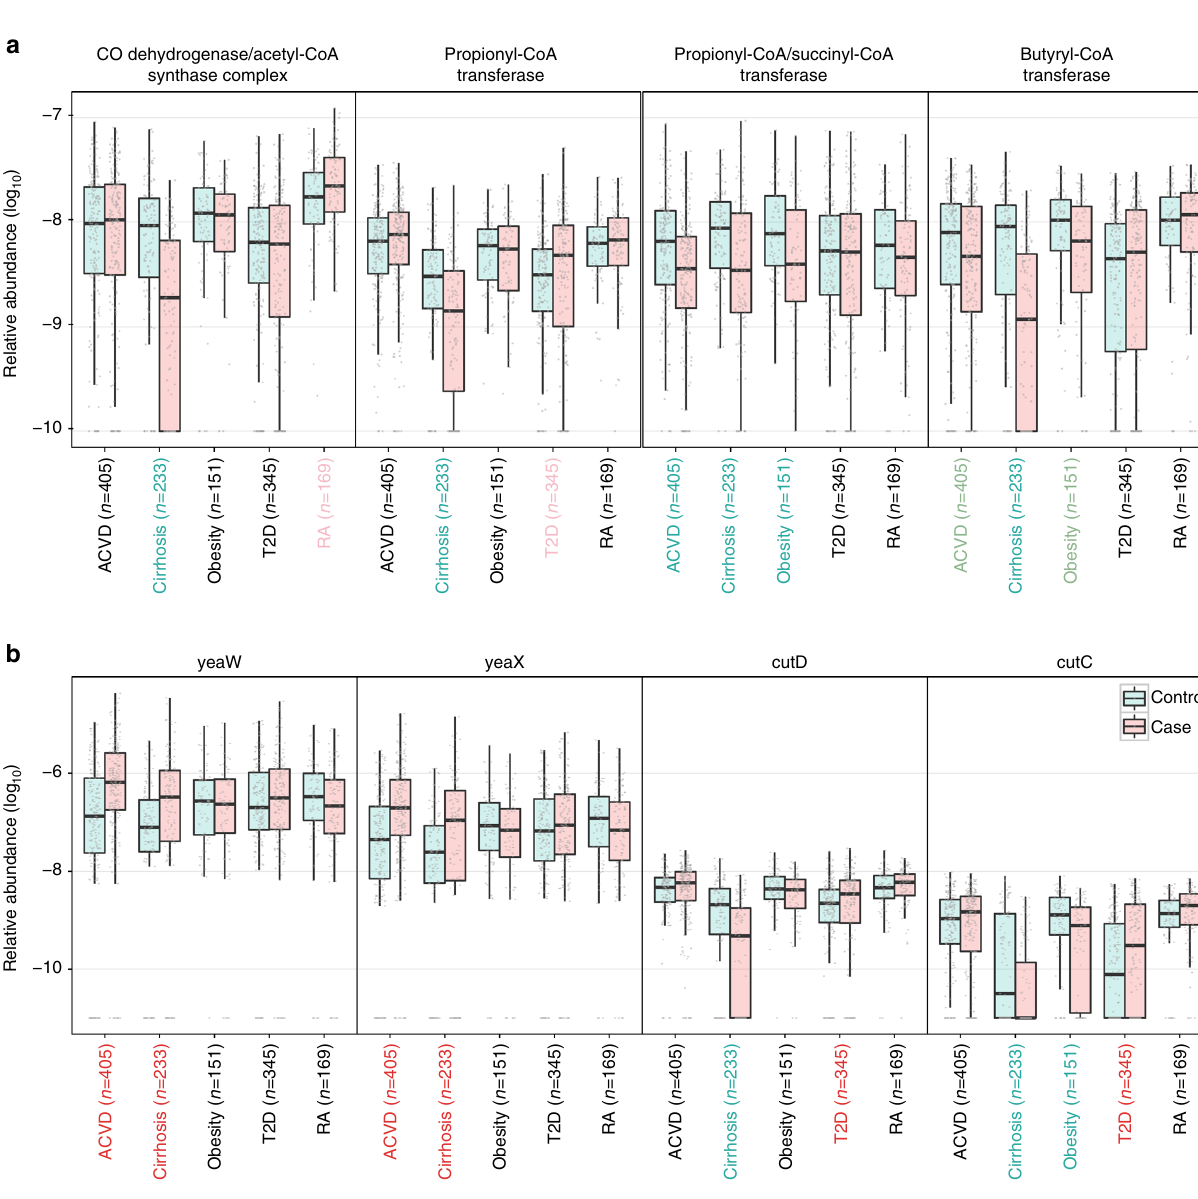
ongoing infectious diseases, cancer, renal, or hepatic failure, peripheral neuropathy, stroke, as well as use of antibiotics within 1 month of sample collection. All the